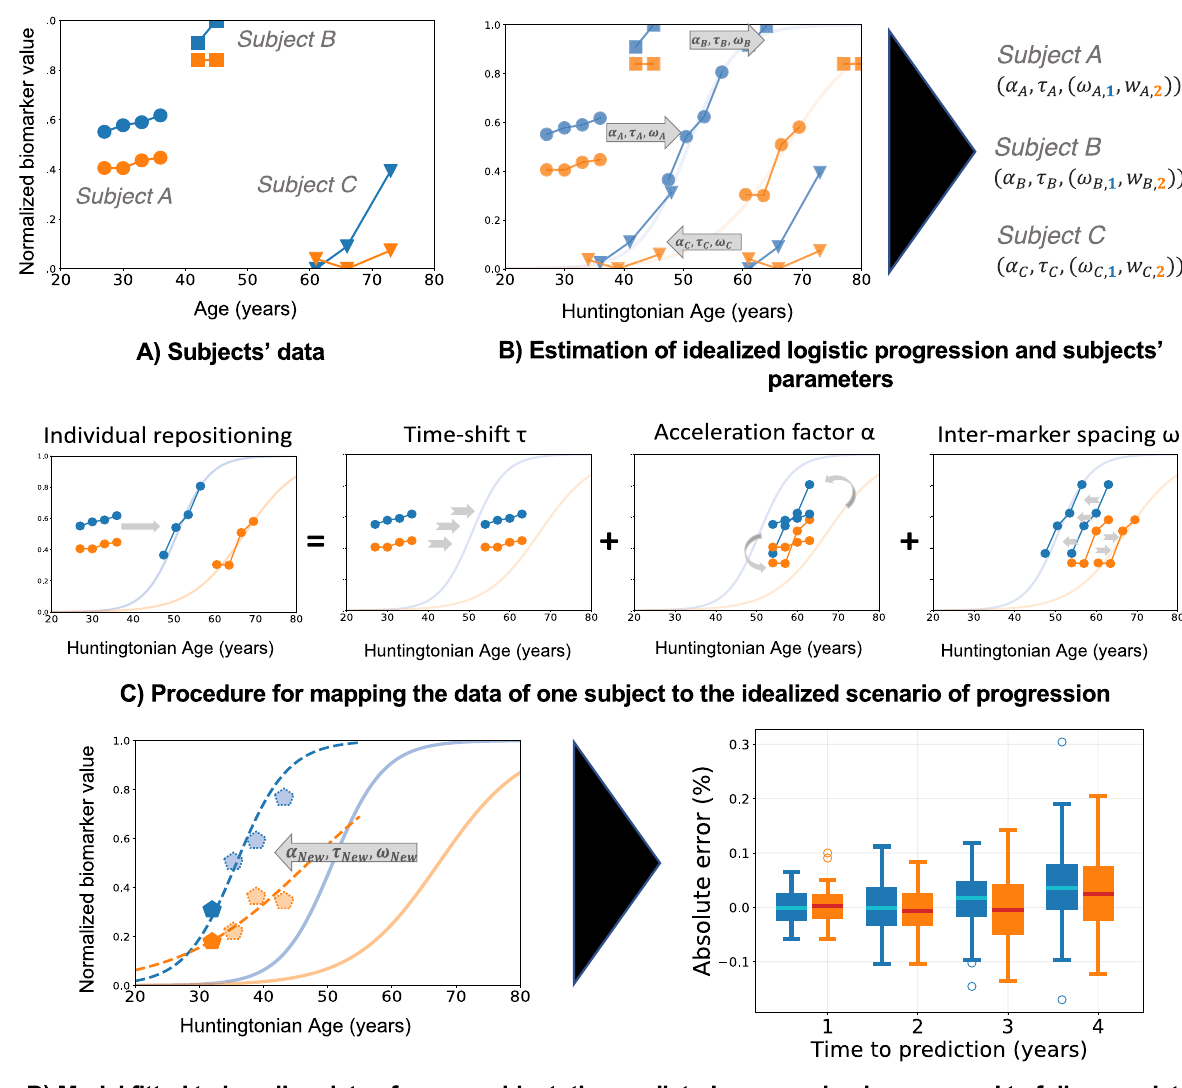
pathological value. Example: subject C shows biomarker values similar to controls at age 60, but the blue biomarker increased to 0.4 at age 72. ( B ) The method estimates two logistic curves for the two biomarkers. They depict the progression of the typical subject in the population and are indexed by HA, a disease stage. These curves are estimated together with the parameters transforming the curves to best fit each biomarker and each subject. ( C ) Three parameters describe the relationship of the logistic curves to the actual data: α (acceleration factor); τ (time shift), and ω (intermarker spacing). The modeling assumes that each subject has a single α, a single τ, and an ω for each biomarker. The method uniquely decomposes differences in dynamics of progression (acceleration factor and time-shift) and disease presentation at the same HA (intermarker spacing) ( D ) The curves are fitted to the baseline data a new subject. The best-fit parameters predict a personalized trajectory of changes of the subject’s biomarkers. The predicted values are compared to the hidden subject’s data at follow-up visits 1–4 years after